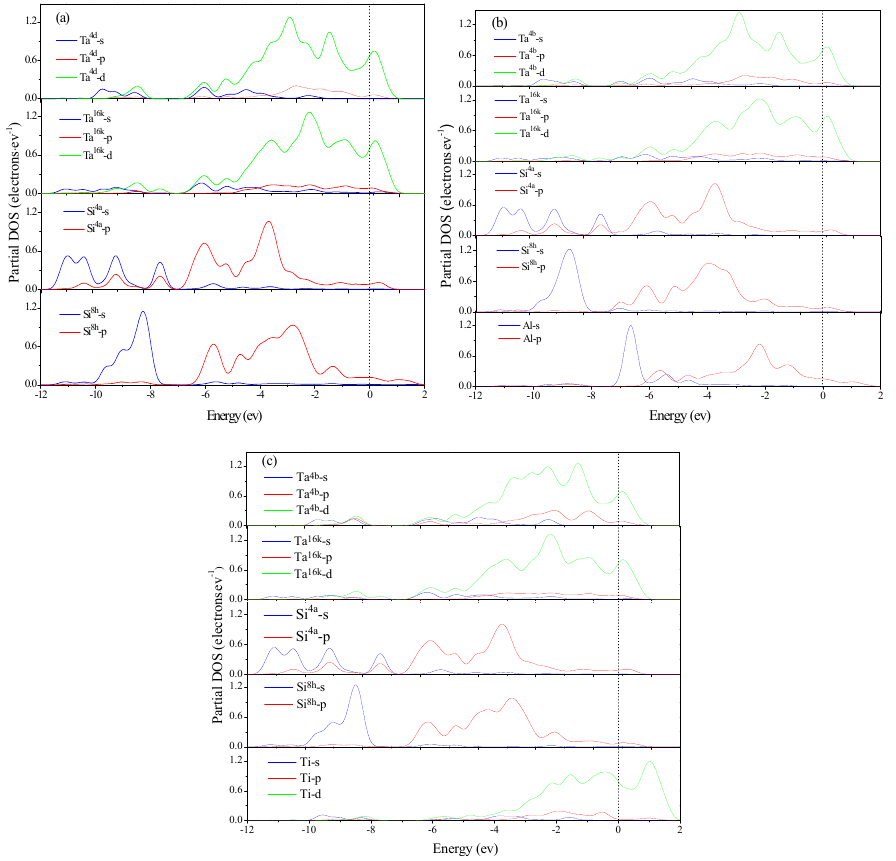
Figure 6. Calculated total density of states (DOS) for ( a ) Ta 20 Si 12 ; ( b ) Ta 20 Si 11 Al 8h and ( c ) Ta 19 Si 12 Ti 4b .